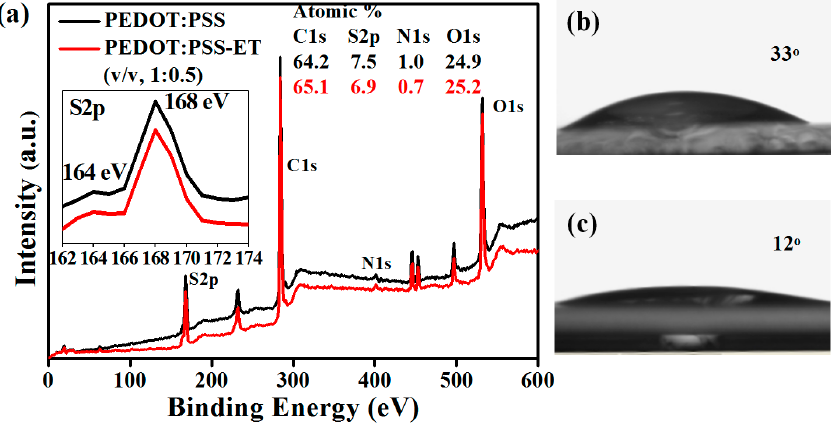
Figure 5. ( a ) XPS survey level C1s, S2p, N1s and O1s data of PEDOT:PSS and PEDOT:PSS-ET ( v / v